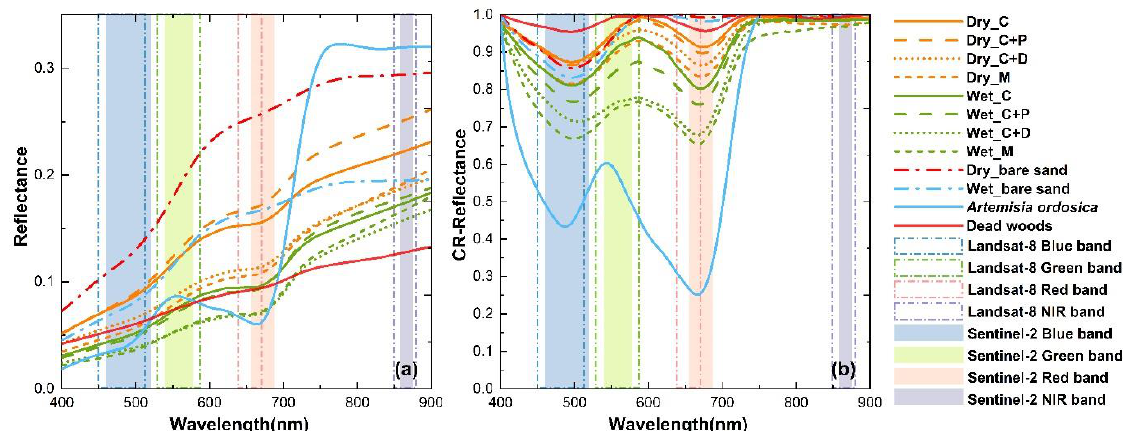
Figure 7. Spectral reflectance and reflectance after CR processing of bare sand, A. ordosica , dead wood, and different cover types with 80%–100% of BSC cover in dry and wet conditions. ( a ) Spectral reflectance at 400–900 nm. ( b ) Spectral reflectance after continuum removal at 400–900 nm. In 80%–100% coverage BSC plots, the replicates of C, C+P, C+D, and M type plots are 14, 7, 10, and 2, respectively.